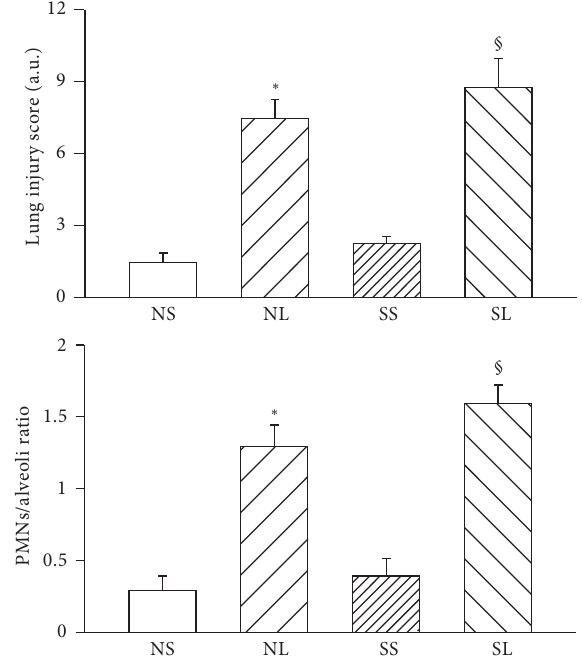
F 6: e lung injury score and PMNs/alveoli ratio in different groups aer LPS administration. NS: normal rats injected with saline; NL: normal rats injected with LPS; SS: STZ-treated rats injected with saline; SL: STZ-treated rats injected with LPS. Data are ,comparedwiththeNSgroup; expressedasmean S.E.M. § ∗ , compared with the SS 𝑃𝑃 𝑃 𝑃𝑃𝑃𝑃 ± 𝑃𝑃 𝑃 𝑃𝑃𝑃𝑃